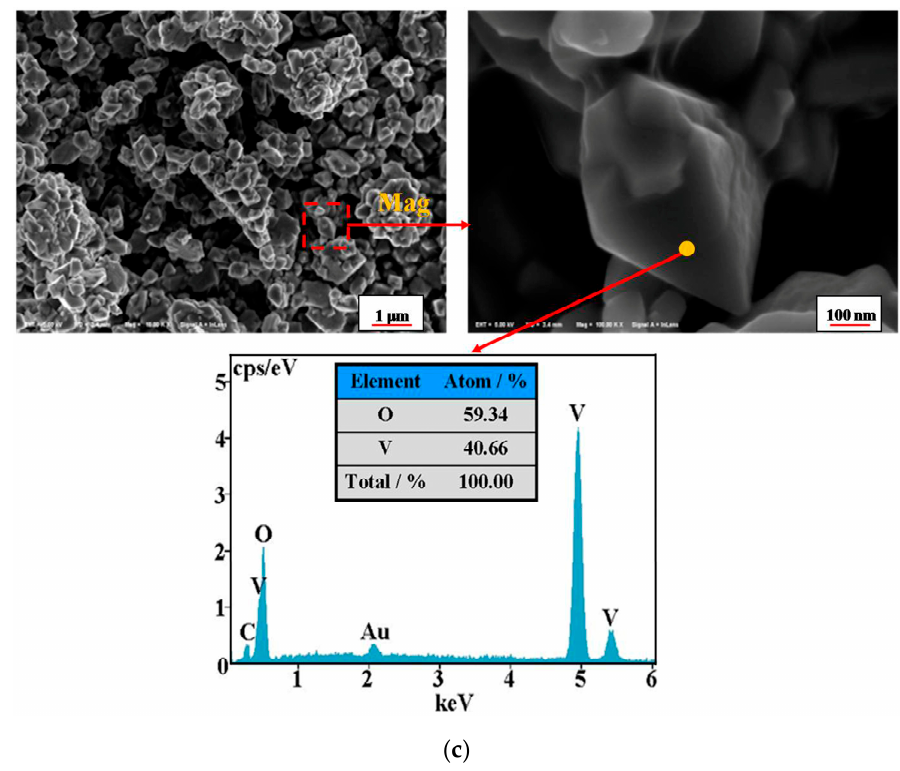
Figure 10. FE-SEM images with EDS analysis of the powders obtained at ( a ) 0.5 h, ( b ) 1 h and ( c ) 2 h.